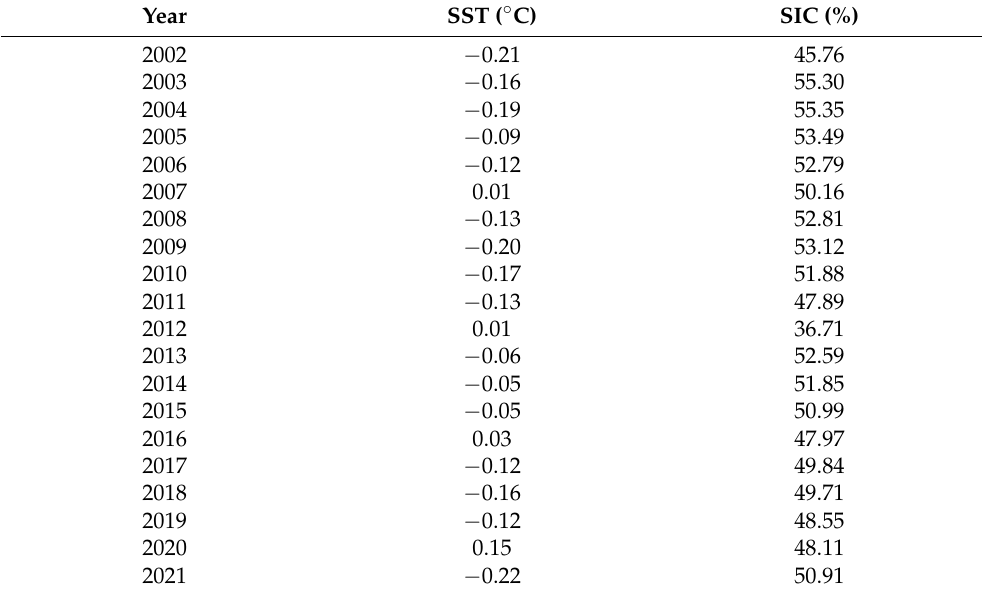
Table 3. SST and SIC in the Arctic, 2002 – 2021.